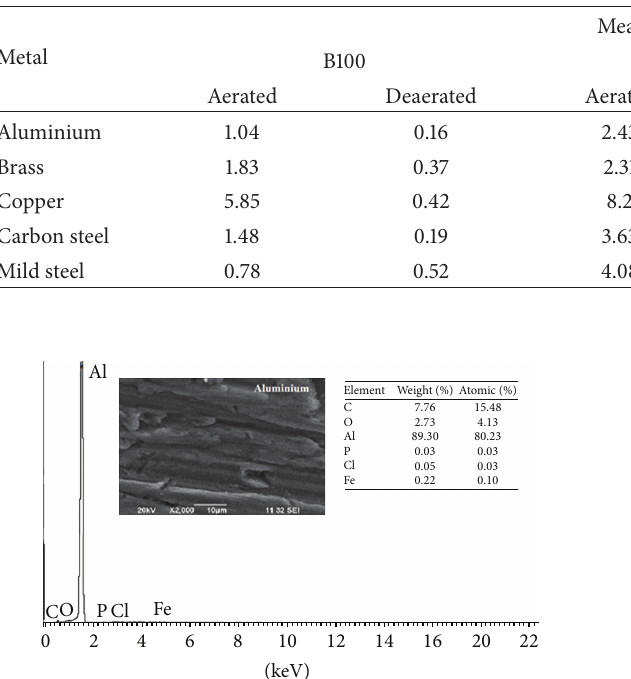
Table 4: Mean corrosion rates of metals in aerated and deaerated conditions.